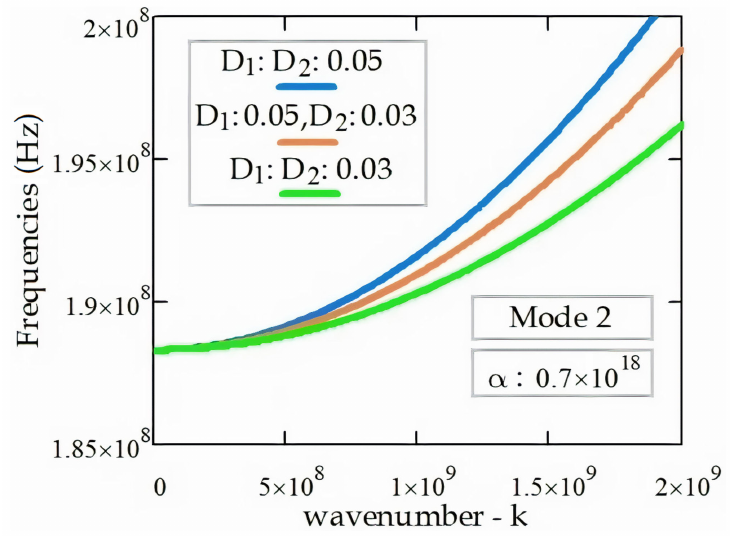
Figure 5. The EM wave dispersion relation (k, ω ) in the DWT according to the different material parameters.